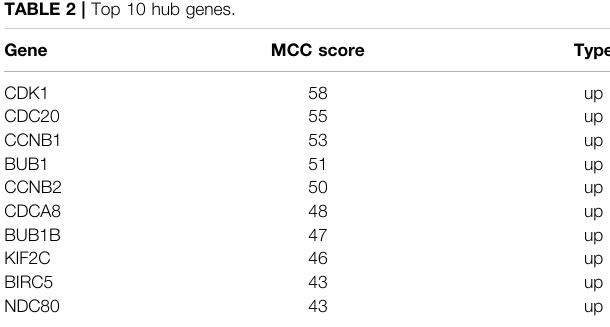
TABLE 2 | Top 10 hub